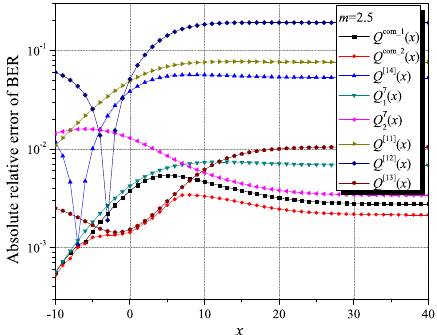
Figure 5. Absolute relative error of determining ASEP for DE-QPSK modulation: comparison of the applied proposed approximations and the selected ones from the